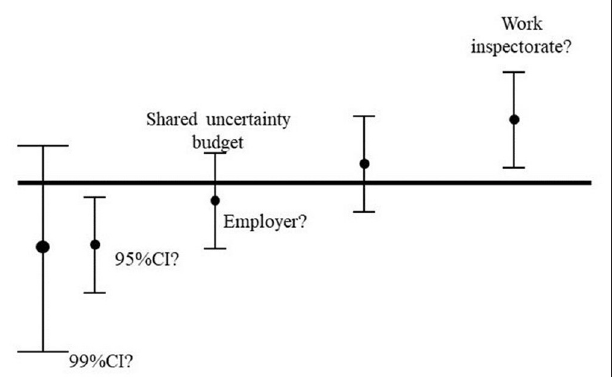
FIGURE 5 | Example of different approaches in uncertainty evaluations depending on the purpose. The error bar visualize a strict legal perspective, the error bar to the left [95% confidence limit (CI)] could be seen from an employee’s perspective—strictly below the limit; whereas the one to the right could be the view of the work inspectorate to see that the company legally are above the